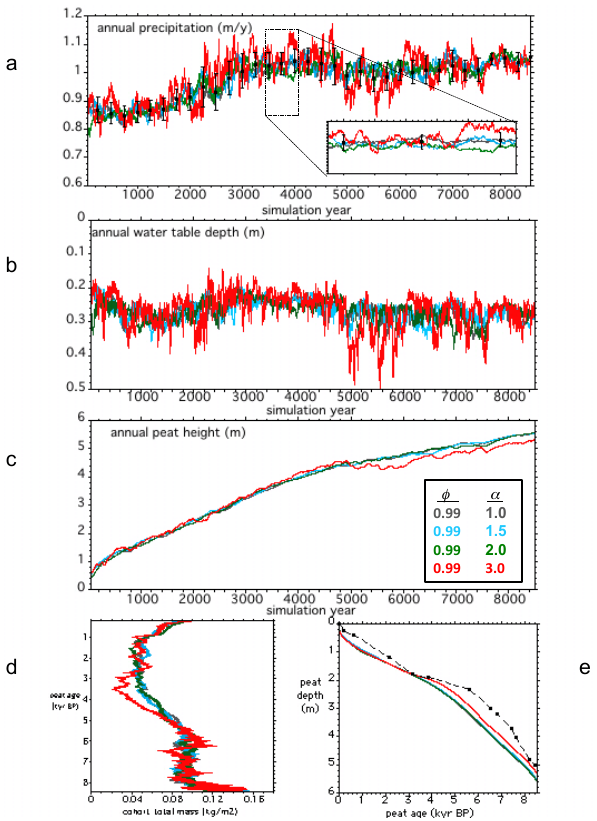
Fig. 8. Same as Fig. 7, but for simulations with α =2.5, and with φ =0.5 (dark gray), 0.7 (cyan), 0.9 (green), and 0.999 (red) (see text and Eqs. 19, 20). In base runs (Figs. 4–6) φ